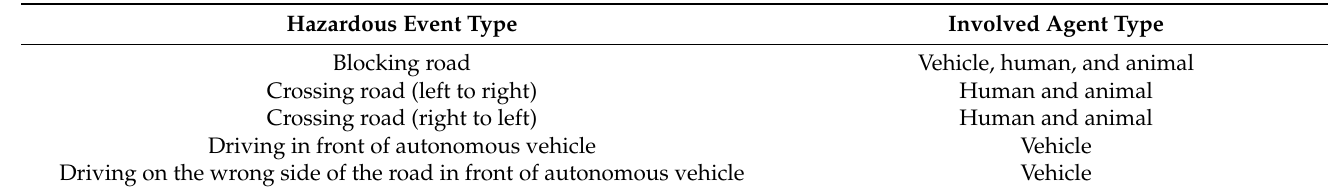
Table 2. Hazardous